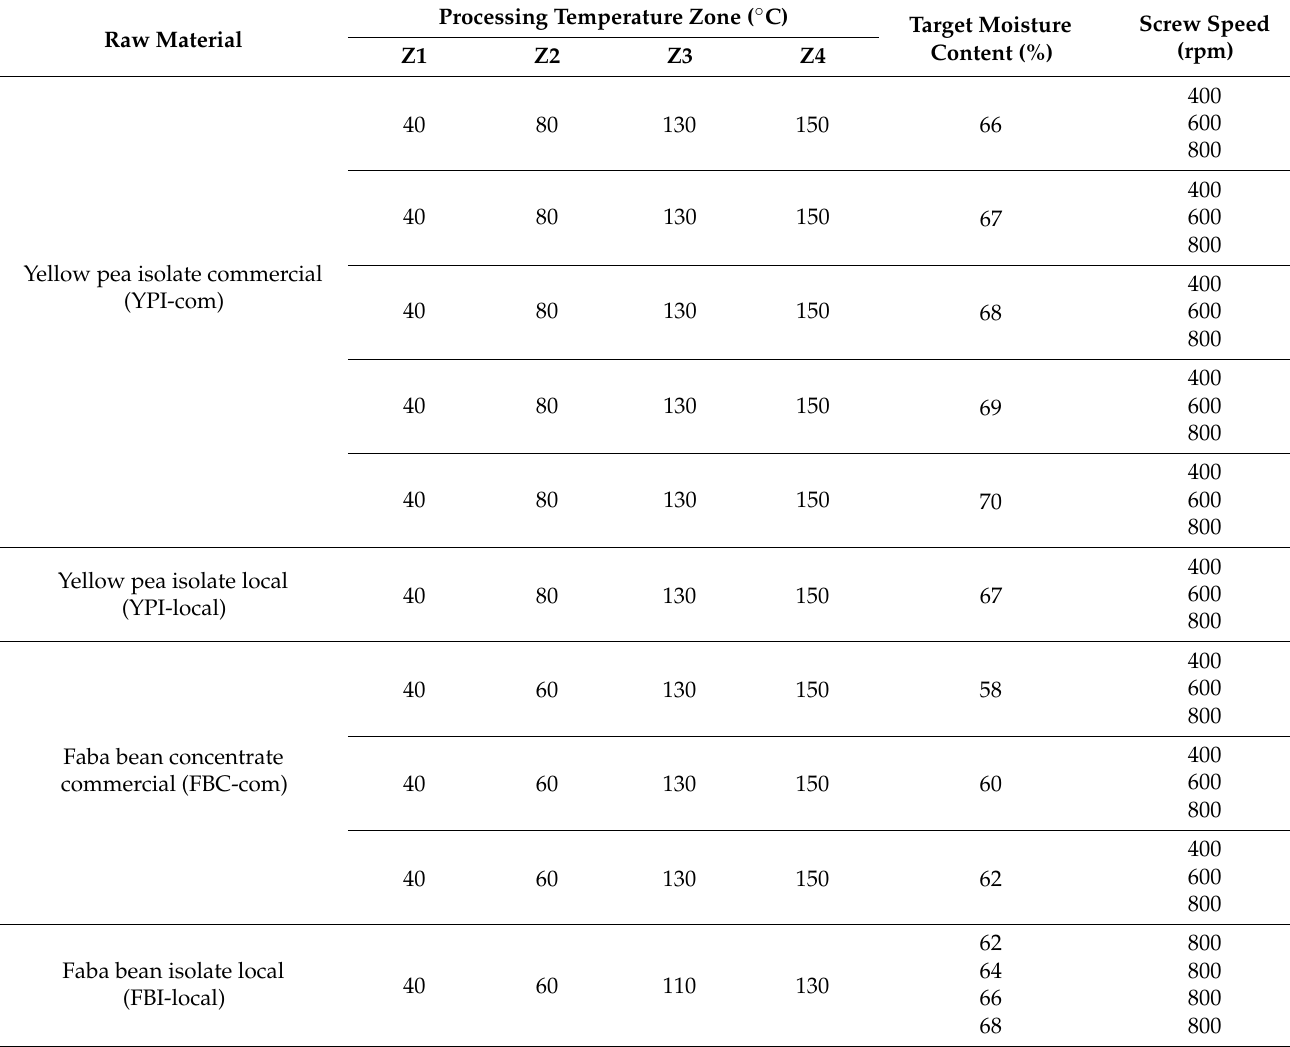
Table A3. Target moisture content and screw speed values tested in preliminary trials after extrusion temperature determi- nation (total mass flow 2